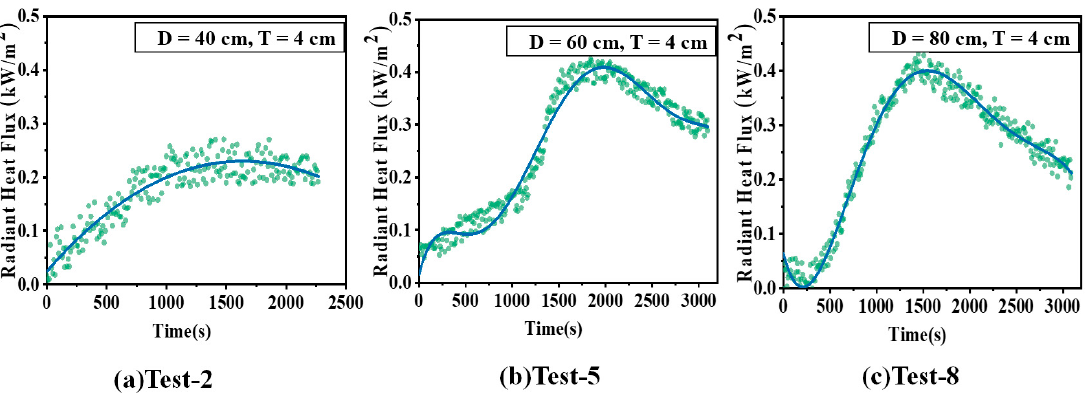
Figure 12. The radiant heat flux changes of Test-2, Test-5, and Test-8 (where ( a ) is a coal pile of 40 cm diameter and 4 cm thickness, ( b ) is a coal pile of 60 cm diameter and 4 cm thickness, ( c ) is a coal pile of 80 cm diameter and 4 cm thickness).